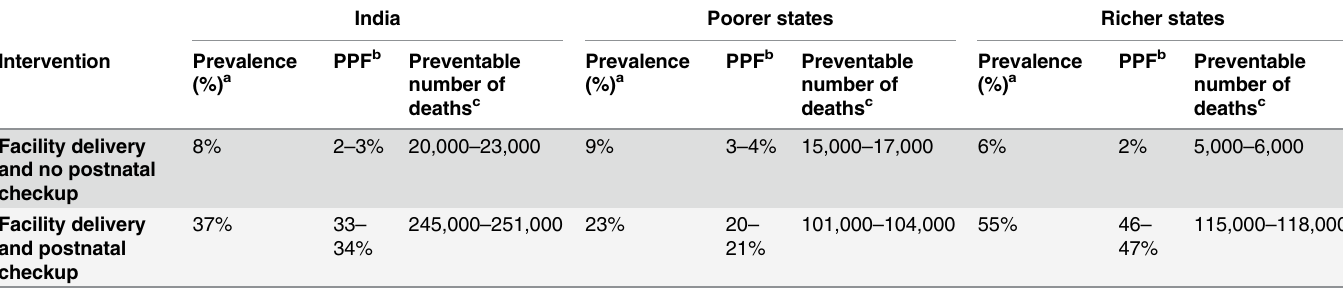
Table 2. Prevalence of exposures, population prevented fraction and preventable number of neonatal deaths in 2014 in India, poorer states and richer states. India Poorer states Richer states